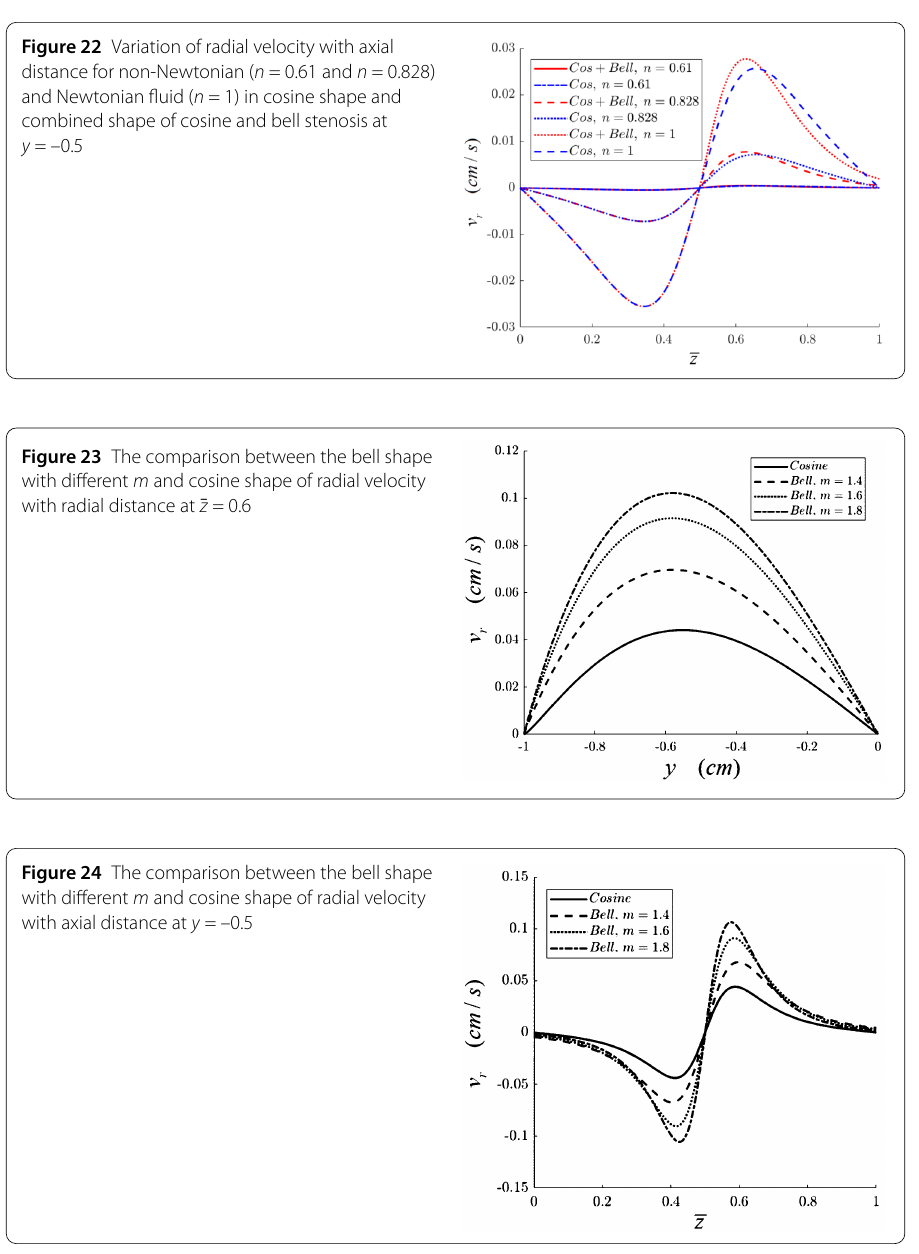
Figure 22 Variation of radial velocity with axial distance for non-Newtonian ( n = 0.61 and n = 0.828) and Newtonian fluid ( n = 1) in cosine shape and combined shape of cosine and bell stenosis at y = –0.5